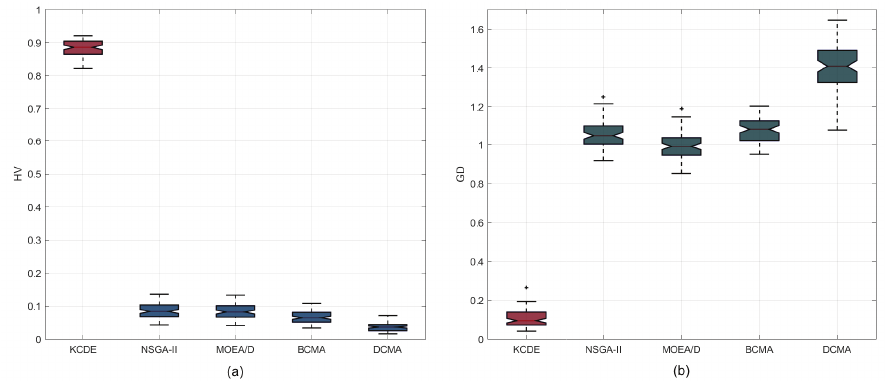
Figure 7. Boxplots of HV and GD of KCDE, NSGA-II, MOEA/D, BCMA and DCMA; ( a ) Boxplots of HV; ( b ) Boxplots of GD.